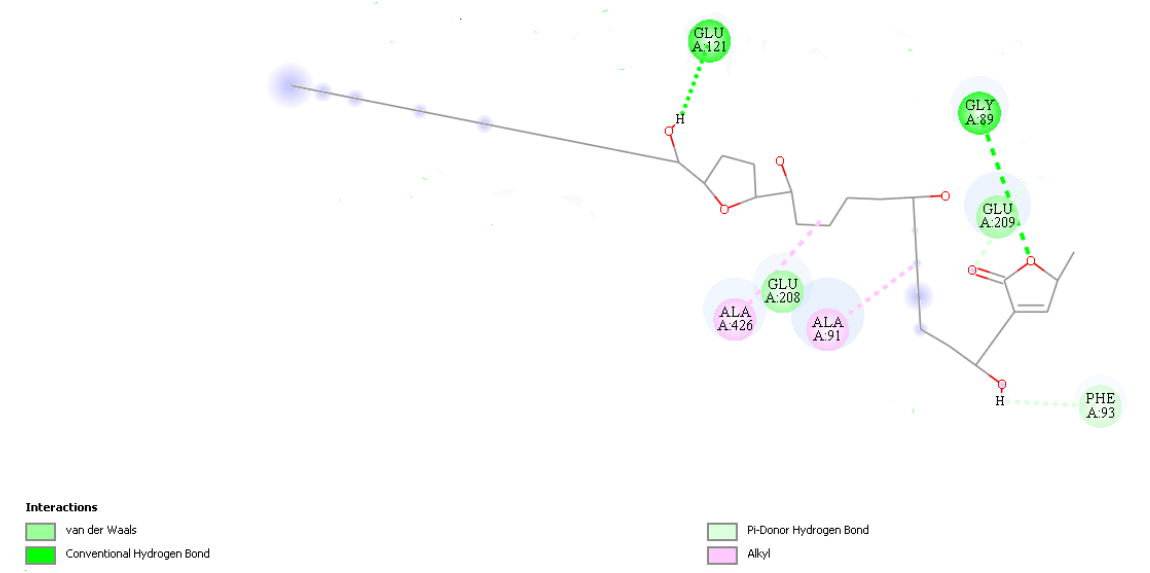
Figure 9. Simulation of connections made between the receptor-ligand. Source: Authors.